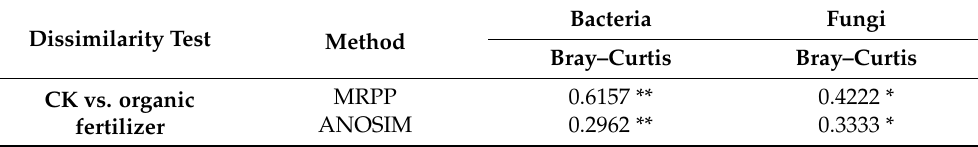
Table 1. Dissimilarity test of the effect of organic matter addition on rhizosphere microbial commu- nity structure.